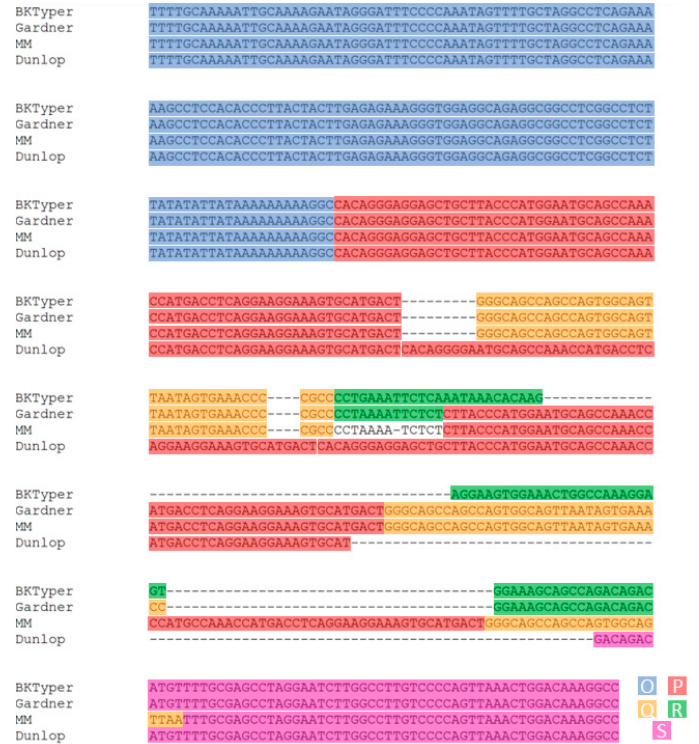
Figure 4. Visual confirmation of the NCCR sequence alignment of Gardner ( LC029411.1 ), MM Figure4. VisualconfirmationoftheNCCRsequencealignmentofGardner(LC029411.1), MM(V01109.1), ( V01109.1 ), and Dunlop ( V01108.1 ) strains. This alignment was constructed by concatenating the and Dunlop (V01108.1) strains. This alignment was constructed by concatenating the di ff erent OPQRS different OPQRS NCCR blocks and posteriorly aligned with Mafft [25]. Diverse color underlying has NCCR blocks and posteriorly aligned with Ma ff t [25]. Diverse color underlying has been used to been used to highlight the different blocks (as blue for O, red for P, yellow for Q, green for R, and highlight the di ff erent blocks (as blue for O, red for P, yellow for Q, green for R, and purple for S). purple for S).